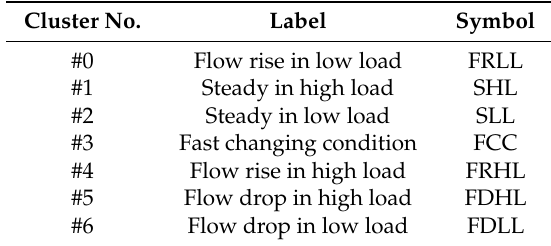
Table 3. Correspondence list between clusters and labels.